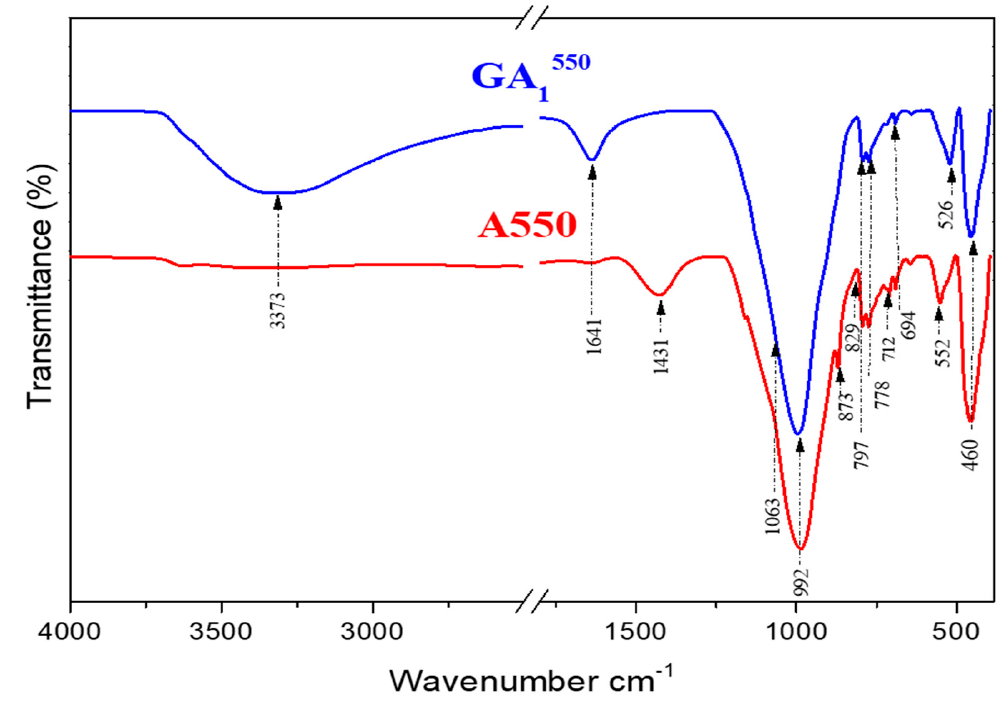
Minerals 2023 , 13 , x FOR PEER REVIEW Figure 12. Infrared spectra of GA 1550 geopolymer aged 7 days and A550 clay. Figure 12. Infrared spectra of GA 1550 geopolymer aged 7 days and A550 clay.